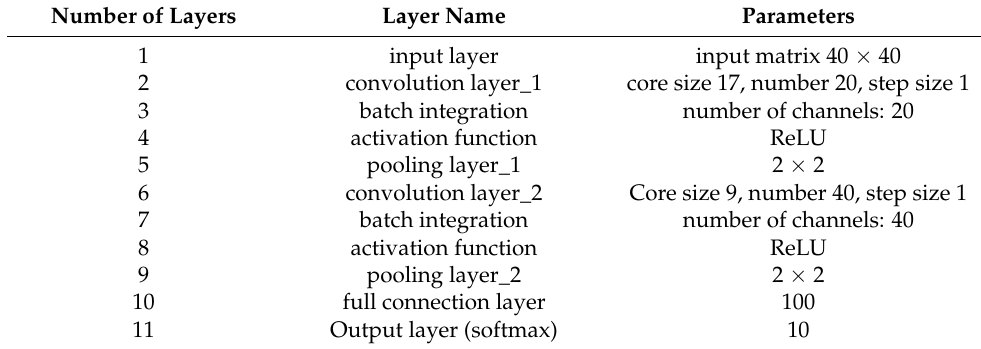
Table 1. Structure parameters of TDCNN.